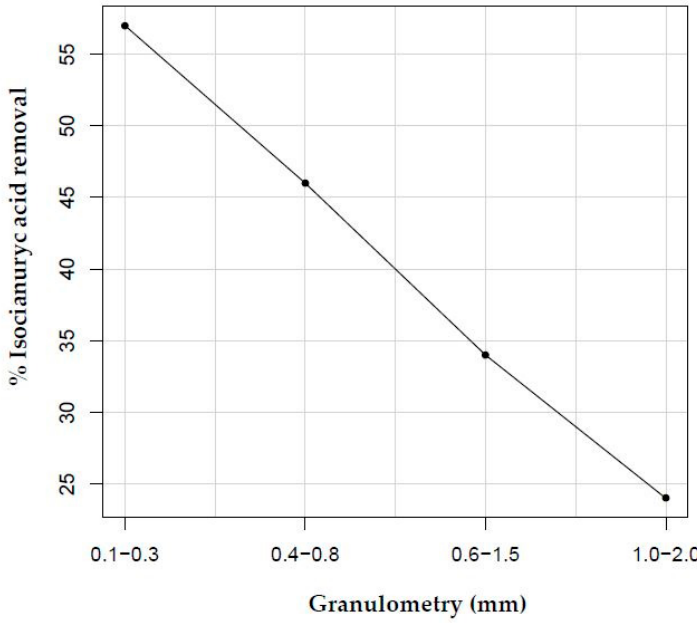
Figure 8. Isocyanuric acid removal rate vs. particle size of the filter medium tested.